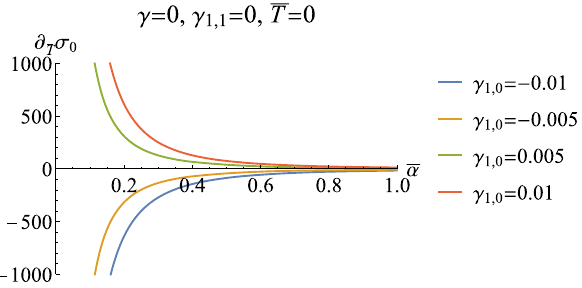
σ ¯ α at zero temperature for different γ Fig. 3 ∂ ¯ 0 as a function of T